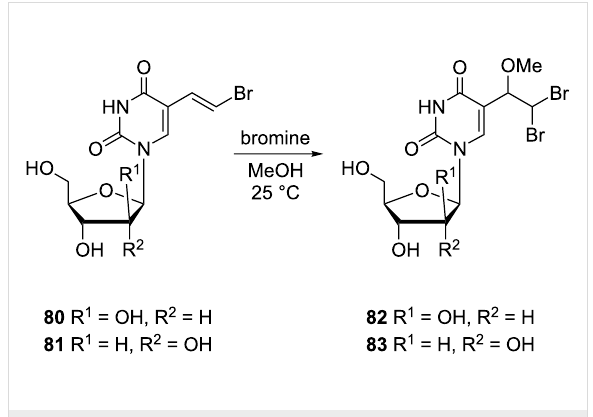
Scheme 12: Synthesis of 1- β -D-arabinofuranosyl-5-(2,2-dibromo-1- methoxyethyl)uracil 82 and uridine analogue 83